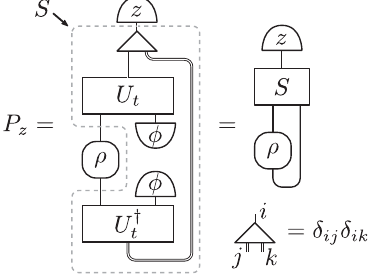
FIG. 3. Tensor diagram illustrating the construction of the scrambling map S in Eq. (3). The thick double lines indicate bonds of dimension d . The three-legged triangle tensor takes ext unit values if the three indices are equal and vanishes